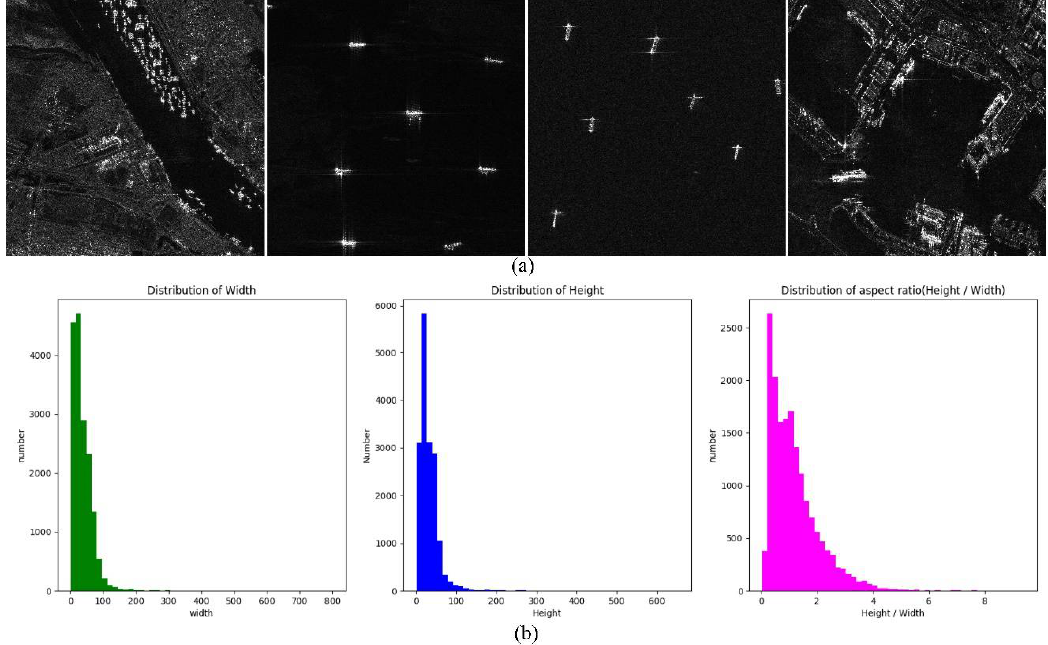
Figure 6. Some samples and shape distributions of HRSID. (a) Some samples. (b) Shape distributions.